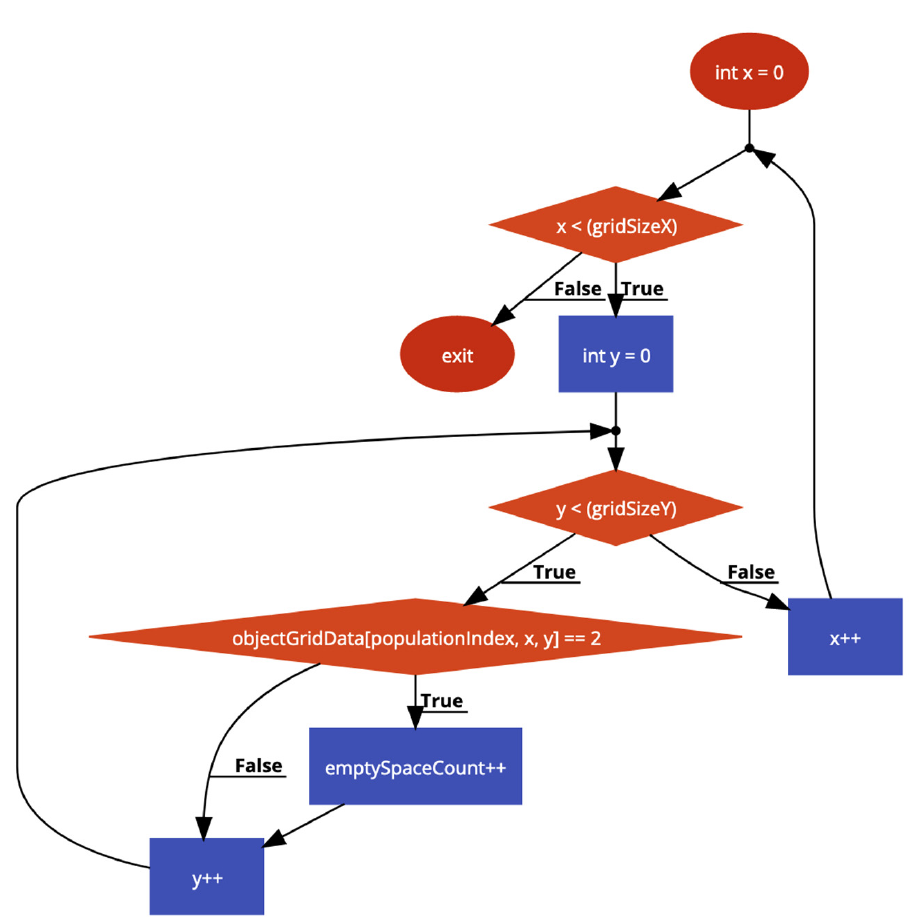
Figure 4. Empty-space balance.